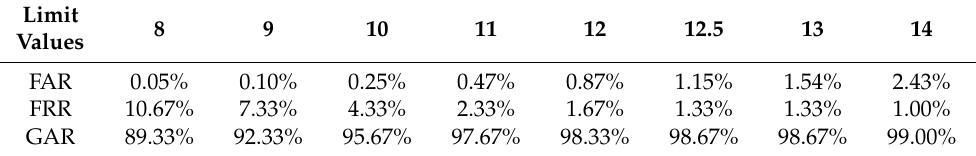
Table 2. FAR, FRR and GAR obtained for the key length of 199 bits and varying absolute limit